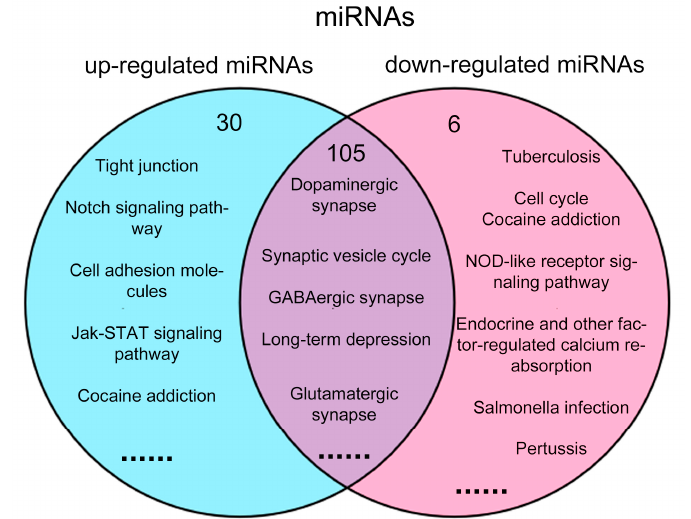
Figure 4. The histogram of target genes for up-regulated miRNAs in GO analysis.